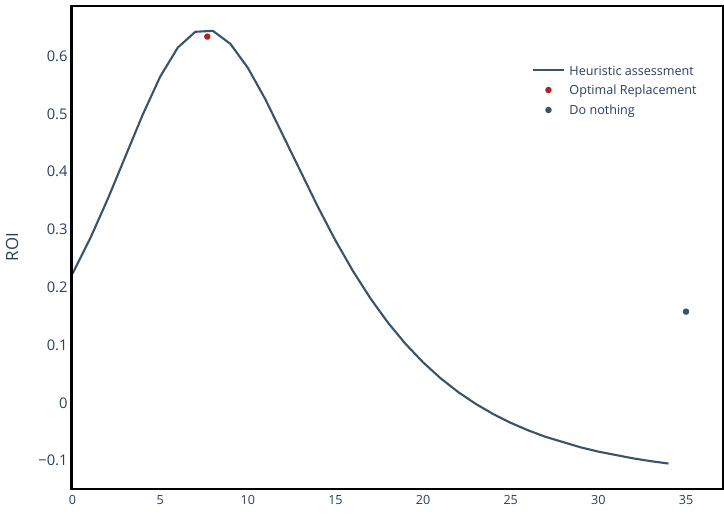
Figure 14. ROI for TR_1 considering different replacement times.